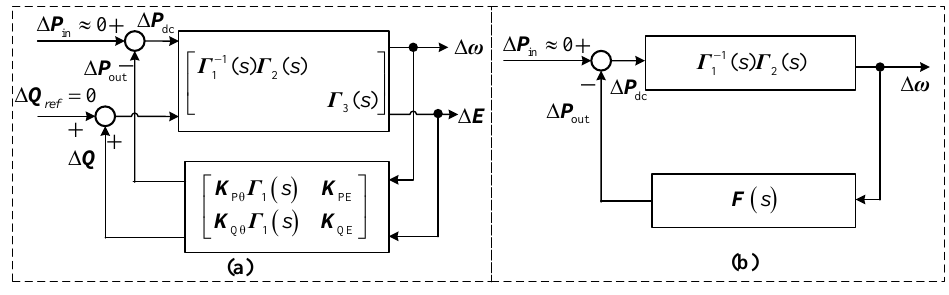
Figure 4. ( a ) The equivalent MIMO system model represented by the transfer function matrix. ( b ) The converted model of the transfer function